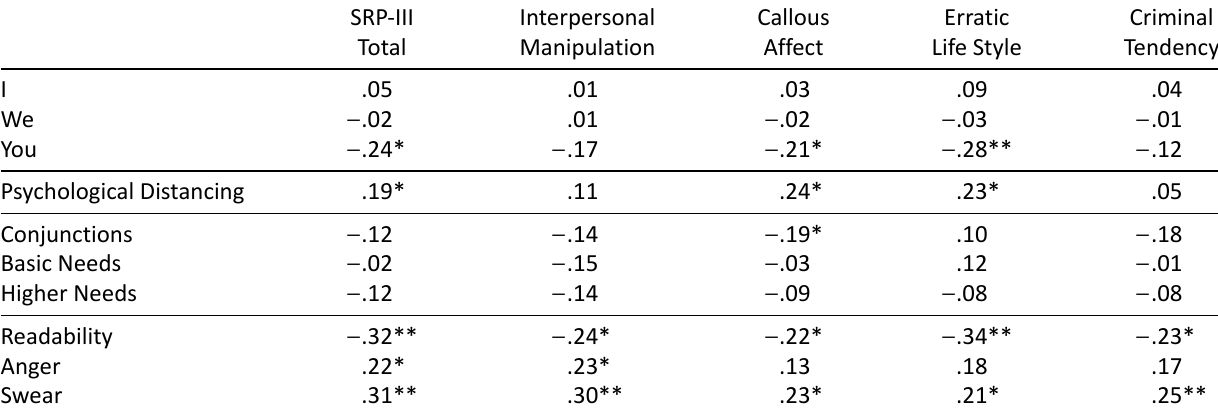
Table 2. Pearson bivariate 2-tailed correlations between SRP-III scores and selected linguistic factors in online